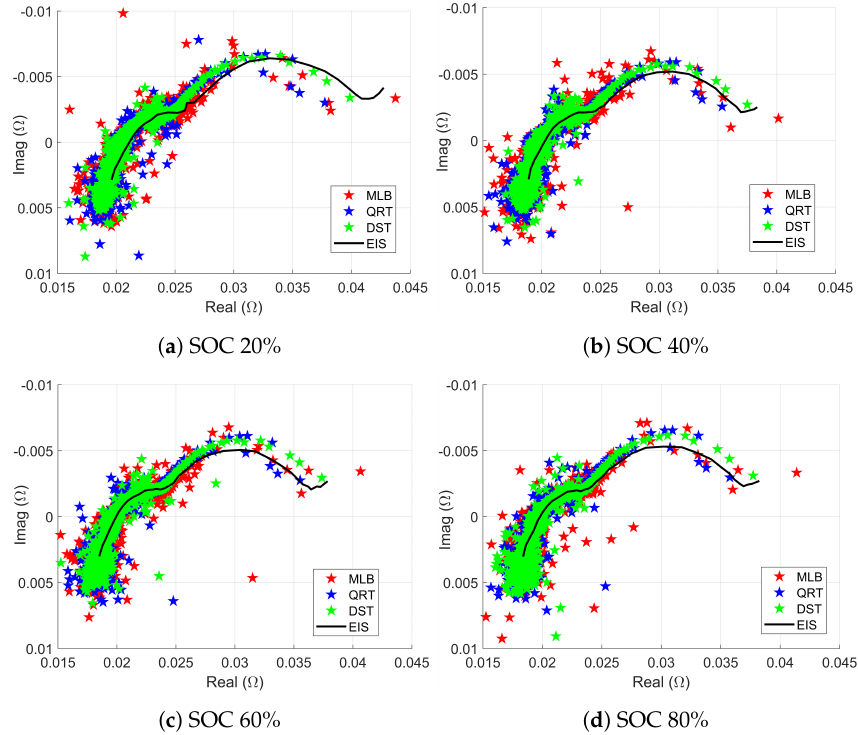
Figure 4. Full-band impedance measurements in the complex-plane at different SOCs.